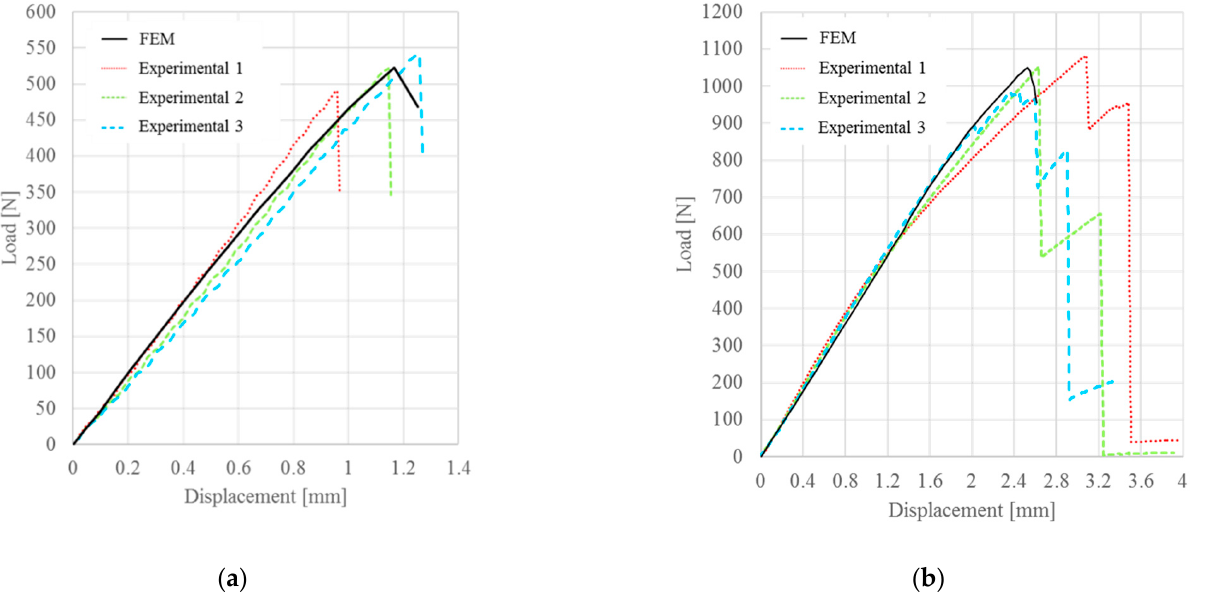
Figure 9. Comparison between experimental and numerical P- δ curve obtained with the linear-exponential law for: ( a ) untreated specimens; ( b ) 13% treated specimens.